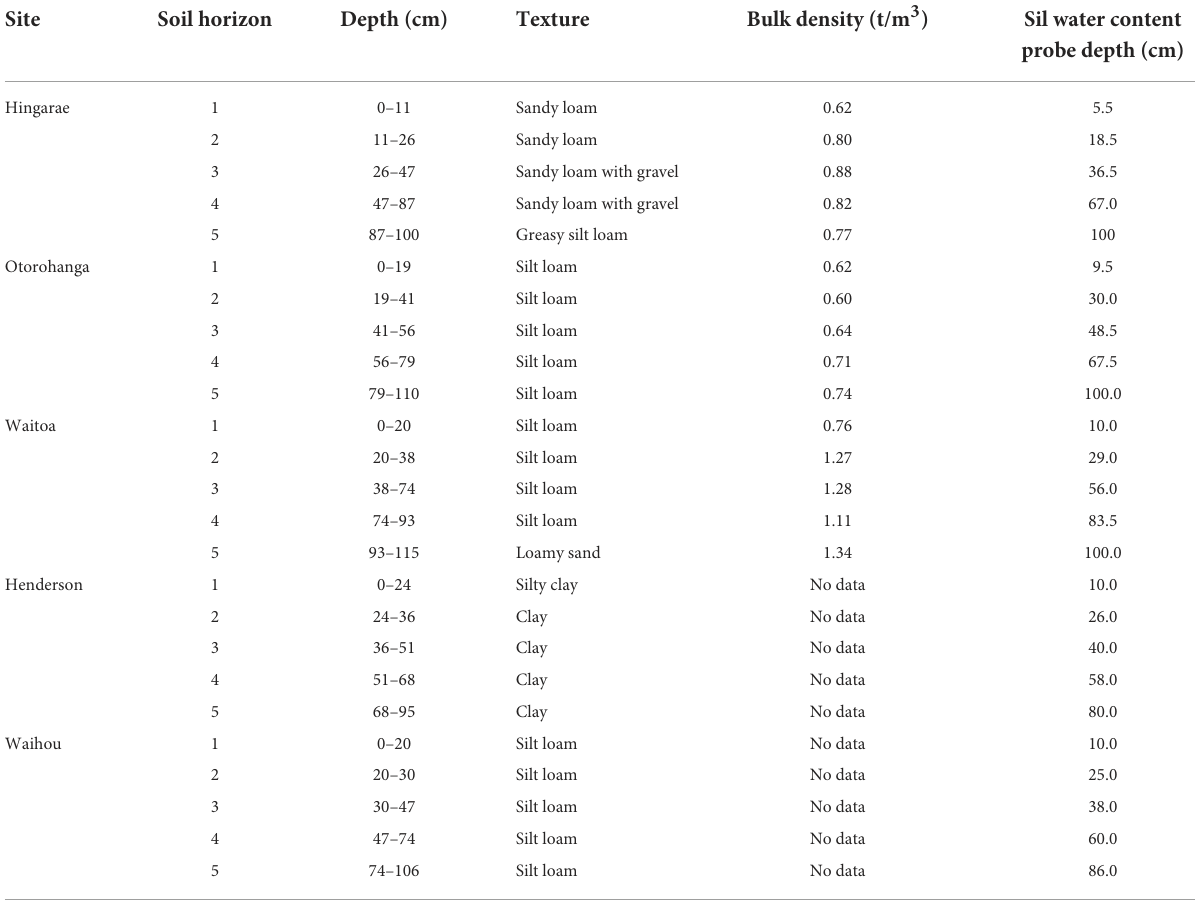
TABLE 4 Soil and soil water content probe information at Waikato sites.